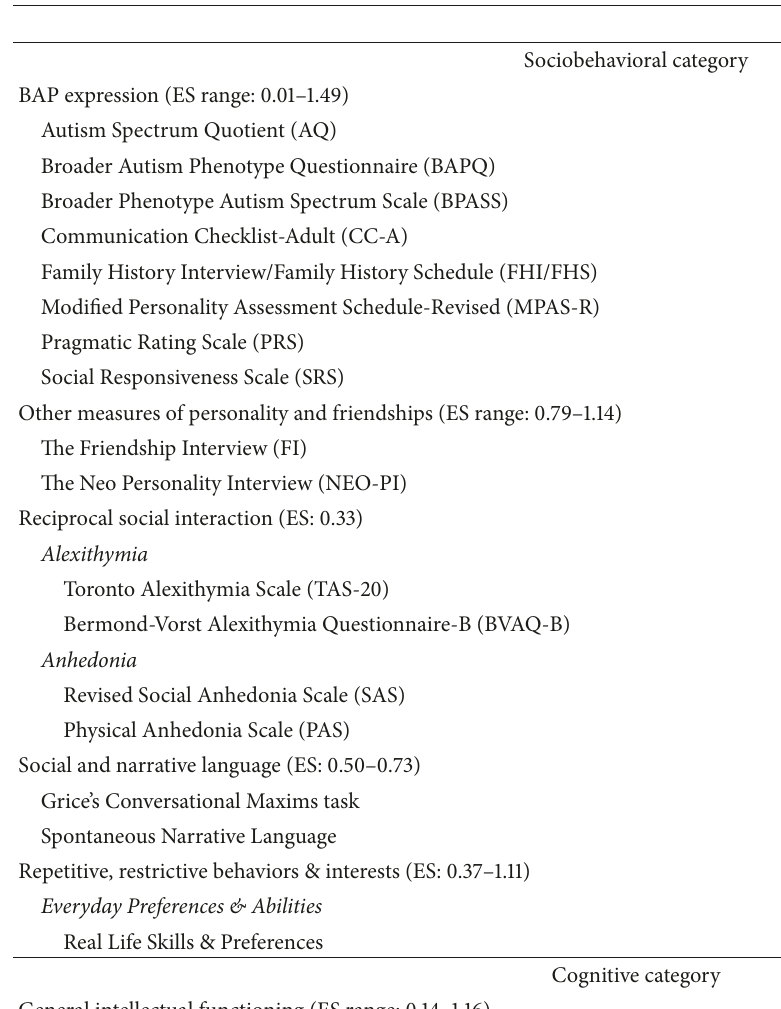
Table 2: Summary of the frequency of all measures used by studies meeting our search criteria and effect size ranges for each domain. Sociobehavioral